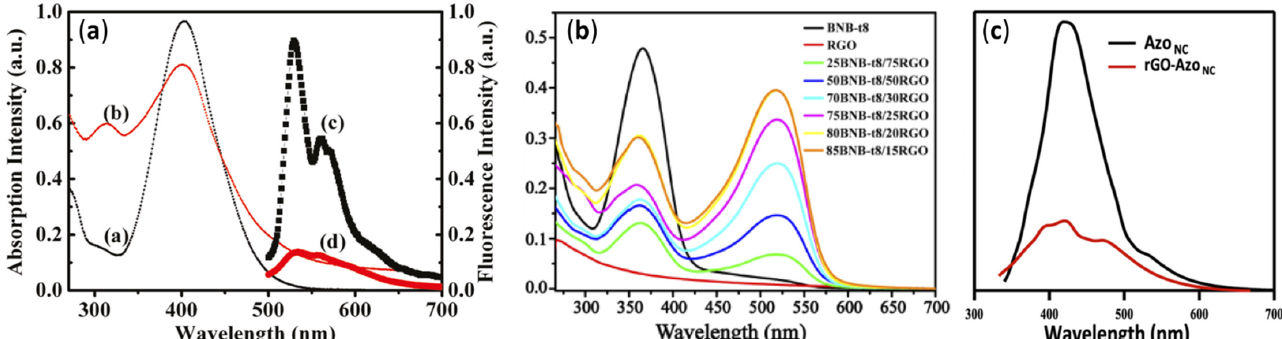
Figure 20. ( a ) UV-Visible spectra (a) GO, (b) GO-AZO and PL spectra of (c) GO and (d) GO-AZO samples by